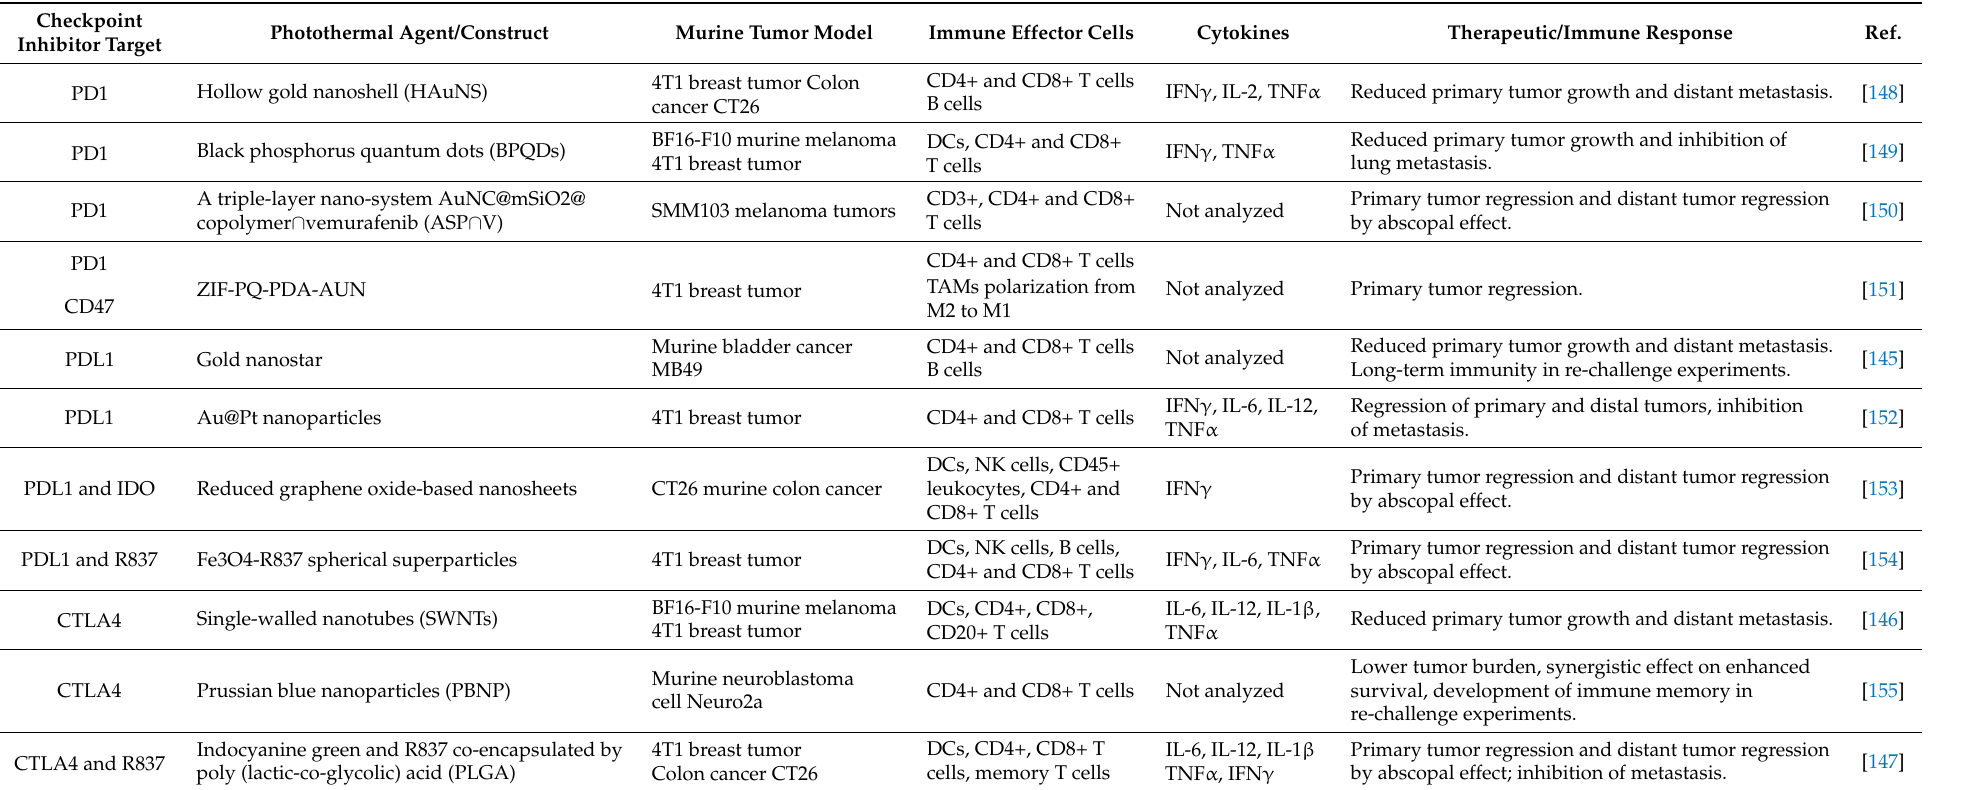
Table 2. A list of selected pre-clinical studies using a combination of immune checkpoint inhibition and photothermal